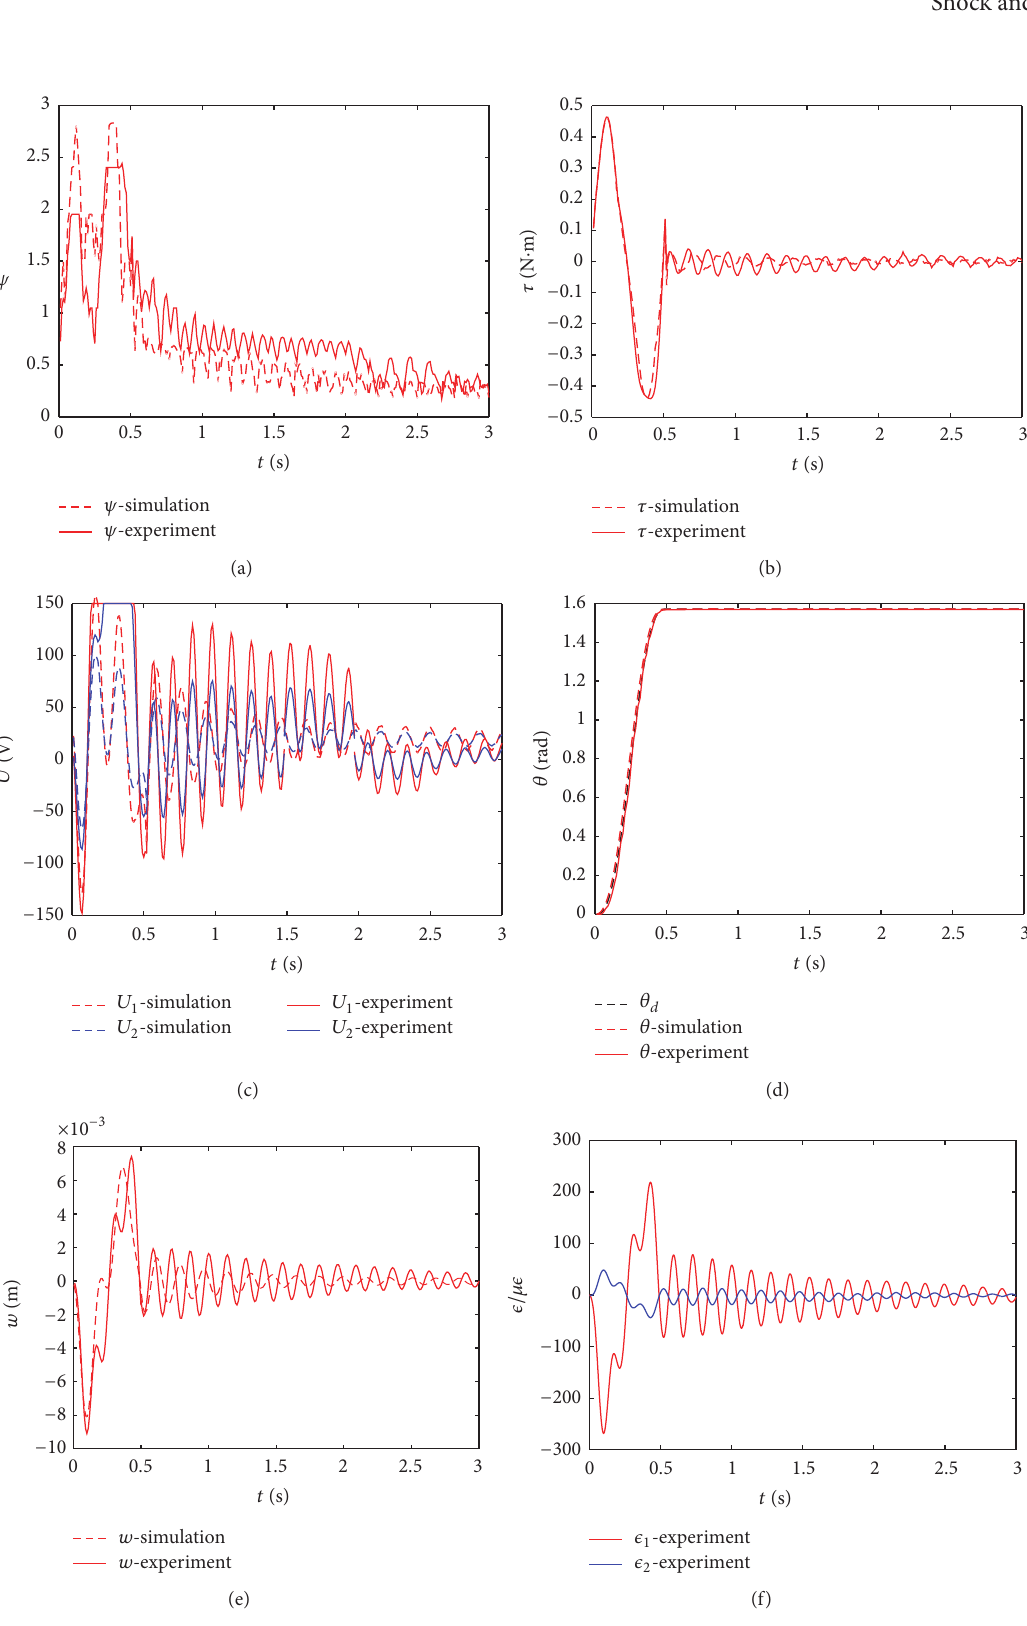
Figure 14: Comparison between the simulated and experimental results of the SFM ((a) time-varying control variable; (b) control torque; (c) control voltage; (d) tip angle; (e) tip deflection; (f) strain